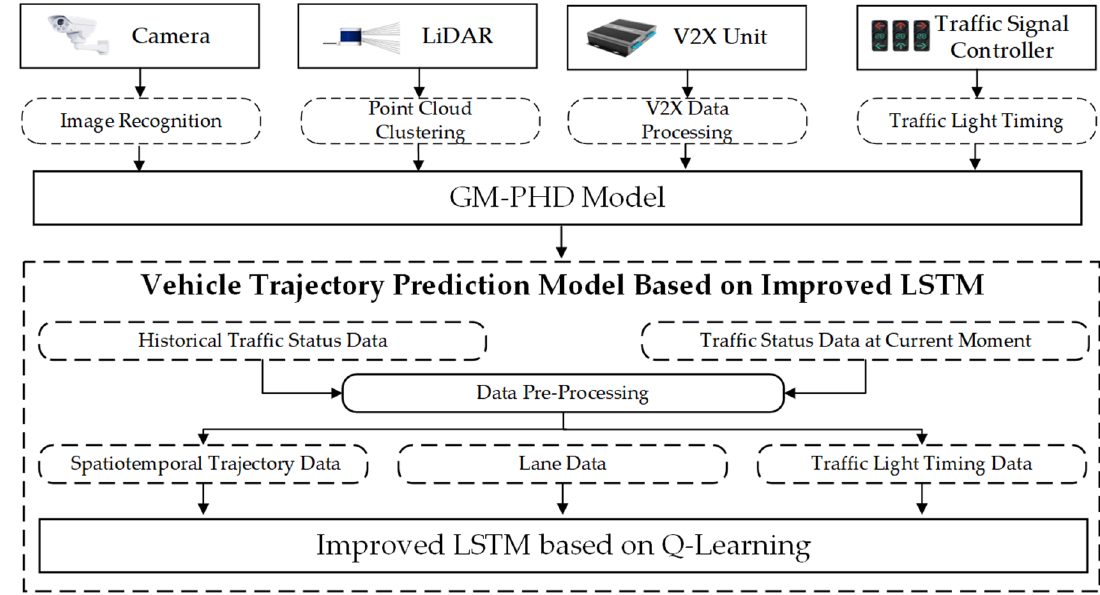
Figure 1. Structure of real-time trajectory prediction method.